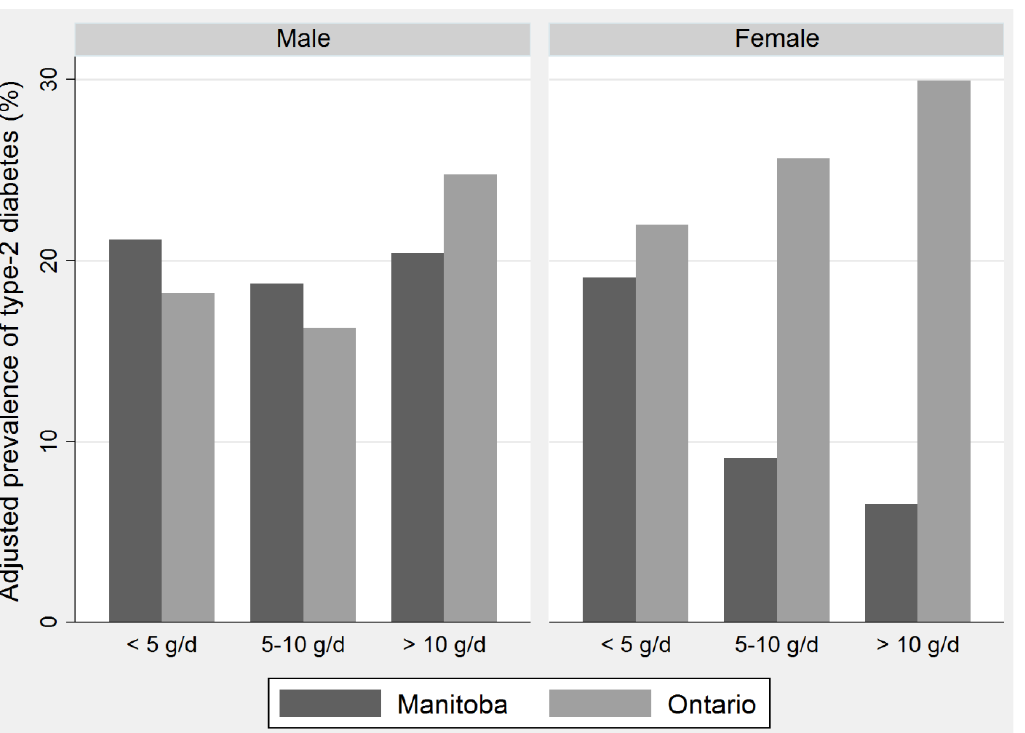
Figure 2. The prevalence of type 2 diabetes by categories of fish intake in Manitoba and Ontario First Nations males and females.